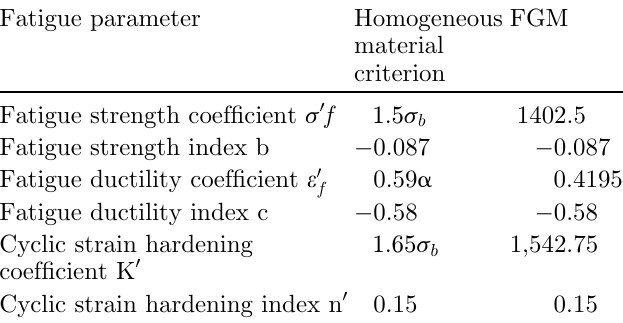
Table 8. Values of FGM fatigue parameters.